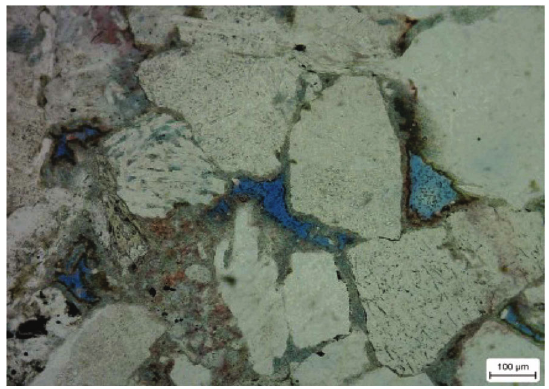
Figure 8: Pore lining chlorite surrounds the remaining intergranular pores, well B202, 3128.6m (-).